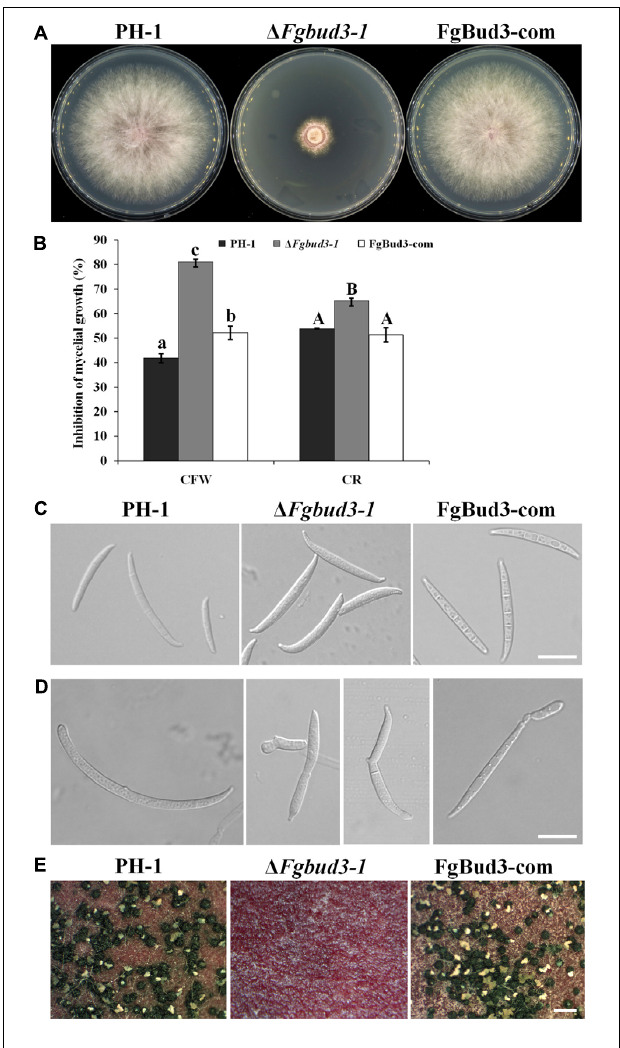
FIGURE 2 | The hyphal growth, asexual and sexual developmental defects of the FgBUD3 deletion mutant. (A) The hyphal growth of strains grown on CM plates. (B) Sensitivity of each strain to 100 µ g/mL CFW and 1.5 mg/mL CR (Congo red). Different letters were used to mark statistically significant difference ( P < 0.05). (C) Conidia produced by PH-1, (cid:49) Fgbud3-1 and FgBud3-com with normal Fusarium-shape. Bar = 20 µ m. (D) Conidia produced by the FgBUD3 deletion mutant with different kinds of abnormal shape. Bar = 20 µ m. (E) The sexual development defect of the FgBUD3 deletion mutant. Bar = 500 µ m. PH-1, wild-type strain; (cid:49) Fgbud3-1 , gene FgBUD3 deletion mutants; FgBud3-com, complemented strain of FgBUD3 deletion